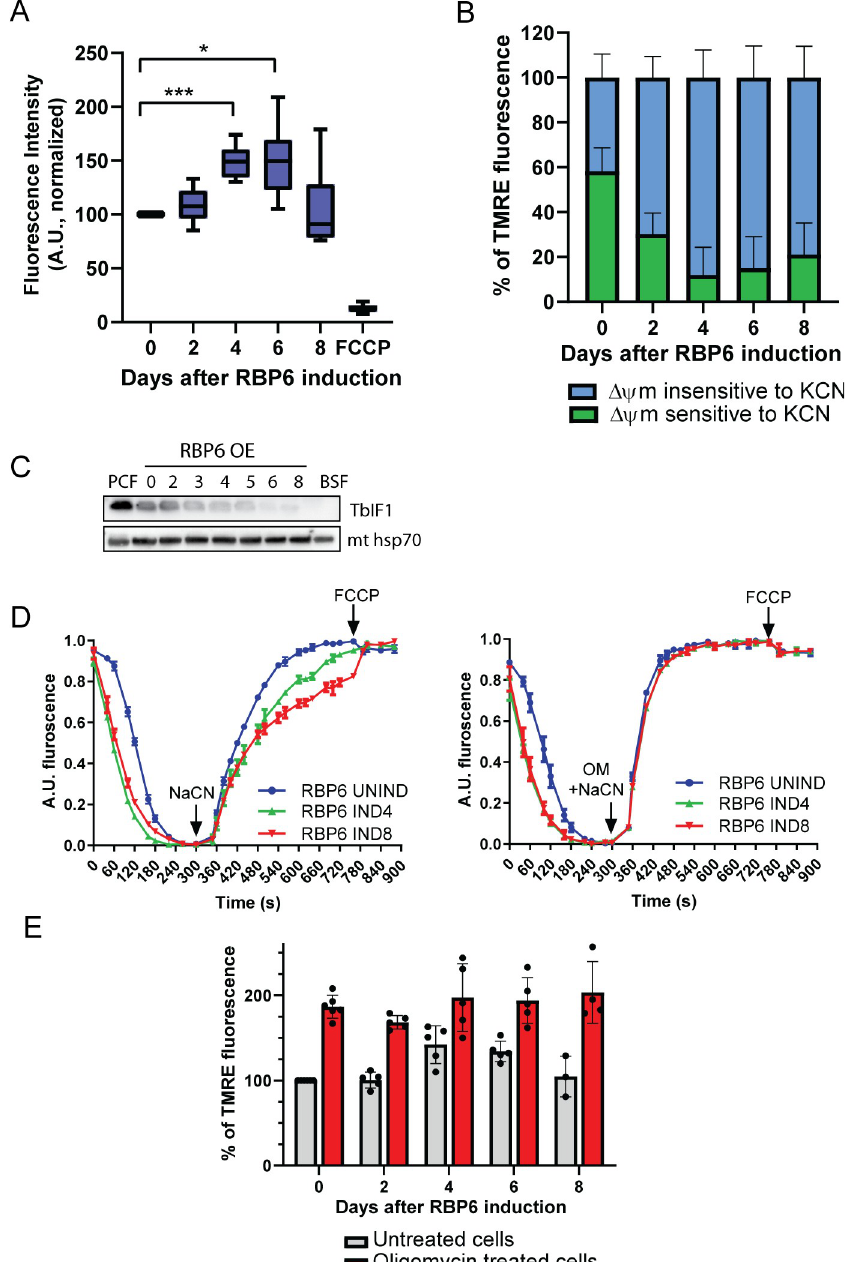
Fig 7. Mitochondrial membrane potential ( Δ ψ m) is increased during RBP6 OE . (A) The Δ ψ m of RBP6 OE cells post induction was measured by flow cytometry using TMRE. A protonophore FCCP serves as a control for membrane depolarization (mean ± SD, n = 6–10) � P < 0.05, ��� P < 0.001. (B) The proportion of Δ ψ m that is generated by complex IV was established by treating the cells with KCN (0.5 mM) in the presence of TMRE for 30 minutes before the analysis. The graph shows a proportion of KCN-sensitive Δ ψ m to the total Δ ψ m measured in each individual sample (mean ± SD, n = 5). (C) Western blot analysis of F o F 1 -ATPase inhibitory factor TbIF1 during RBP6 OE . Mitochondrial (mt) hsp70 serves as a loading control. (D) The in situ dissipation of the Δ ψ m in response to chemical inhibition of complex IV by 1 mM NaCN was measured using safranine O dye in RBP6 OE uninduced (UNIND) cells and cells induced for 4 and 6 days. The reaction was initiated with digitonin; OM, oligomycin (2.5 μ g/mL), and FCCP (5 μ M) were added when indicated (mean ± SD, n = 3). (E) The Δ ψ m of RBP6 OE cells that were treated (red columns) or not with oligomycin (2.5 μ g/mL). Individual values shown as dots (mean ± SD, n = 3–6). Underlying data plotted in panels A, B, D, and E are provided in S1 Data. BSF, bloodstream cell; FCCP, carbonyl